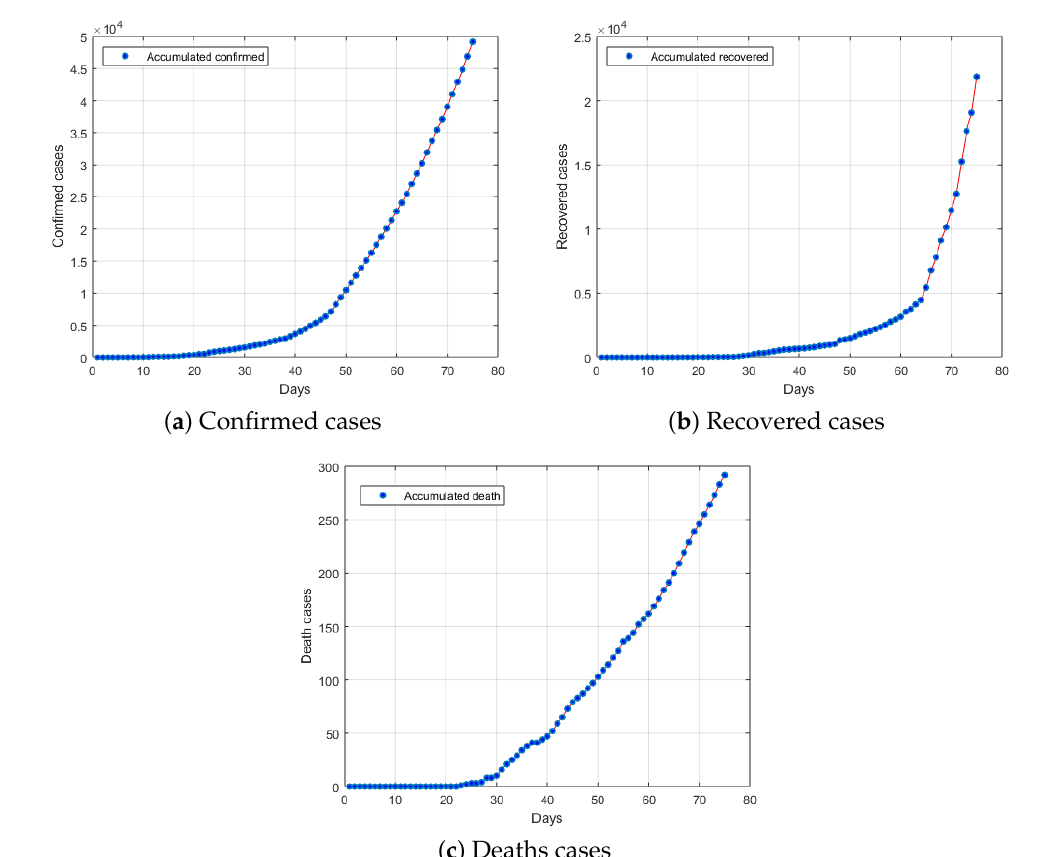
Figure 1. Number of ( a ) confirmed, ( b ) recovered and ( c ) deaths cases related to COVID-19 in